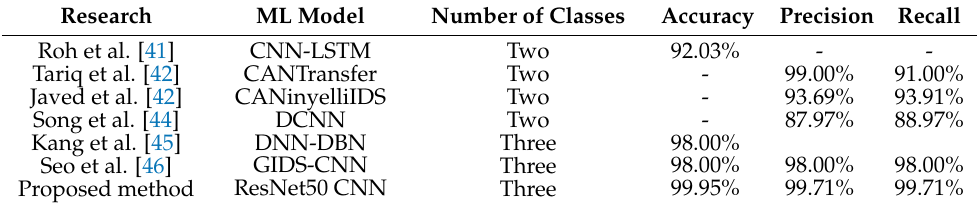
Table 3. Comparing the performance of our proposed model with existing detection models.